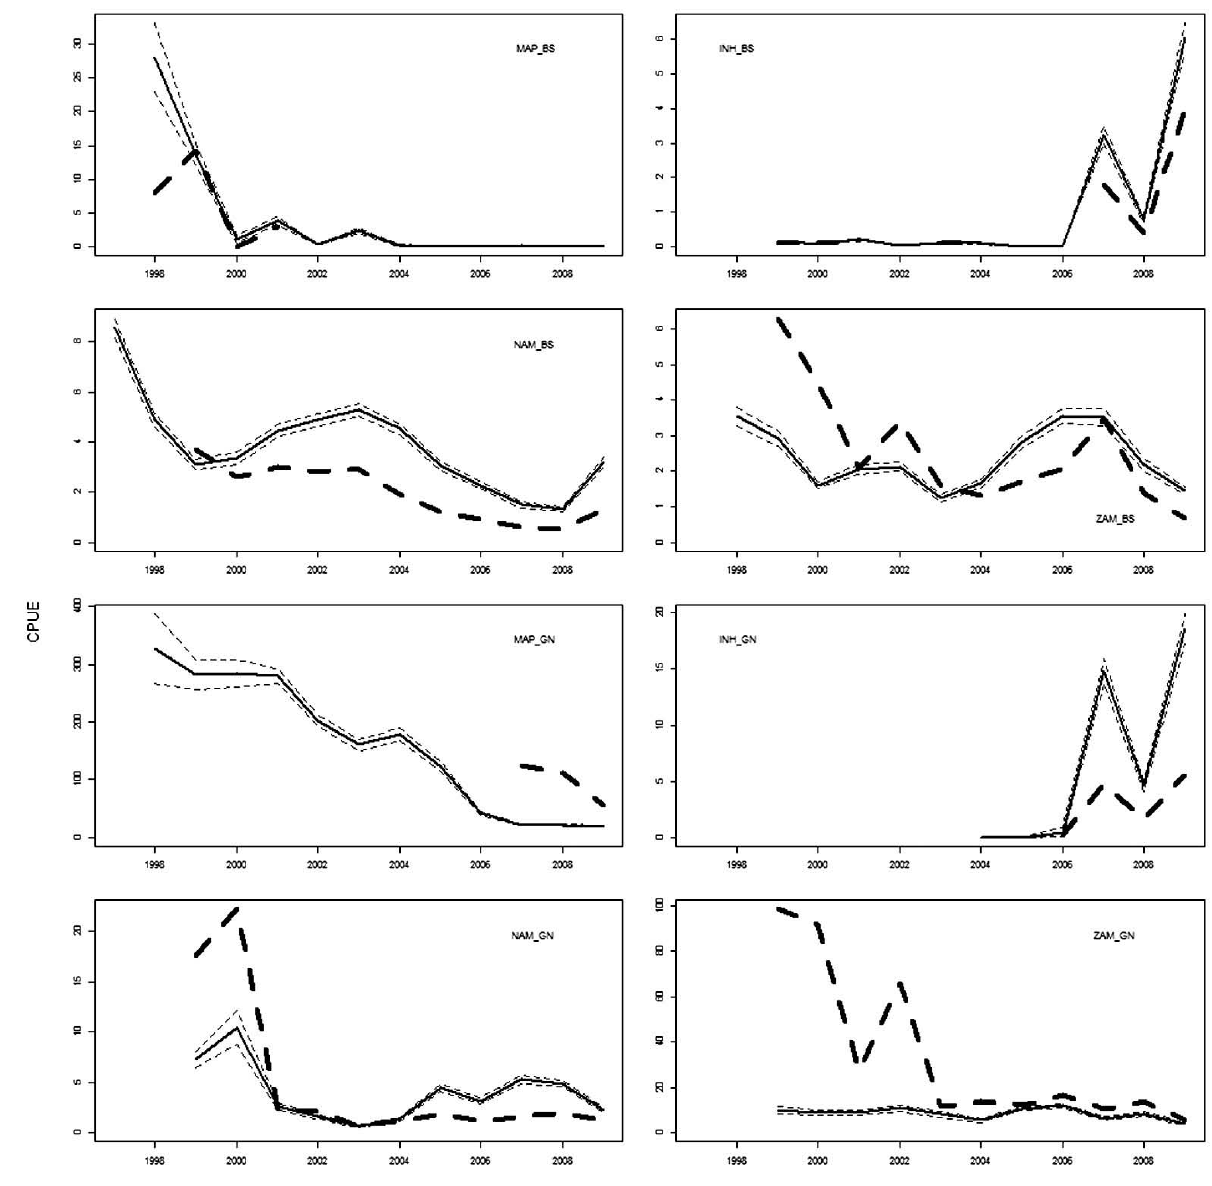
Fig. 5. – Yearly average CPUE (kg day –1 , continuous line) and CPUENET [kg day –1 (m of nets) –1 , dashed line] of Hilsa kelee with the 95% confidence intervals as estimated by the GAMs for the provinces and gears analysed using final models (see Table 3 for details). CPUENET is multiplied per 100 for a straightforward representation, except for MAP_BS, which was multiplied per two. See Table 3 for model code and statistical